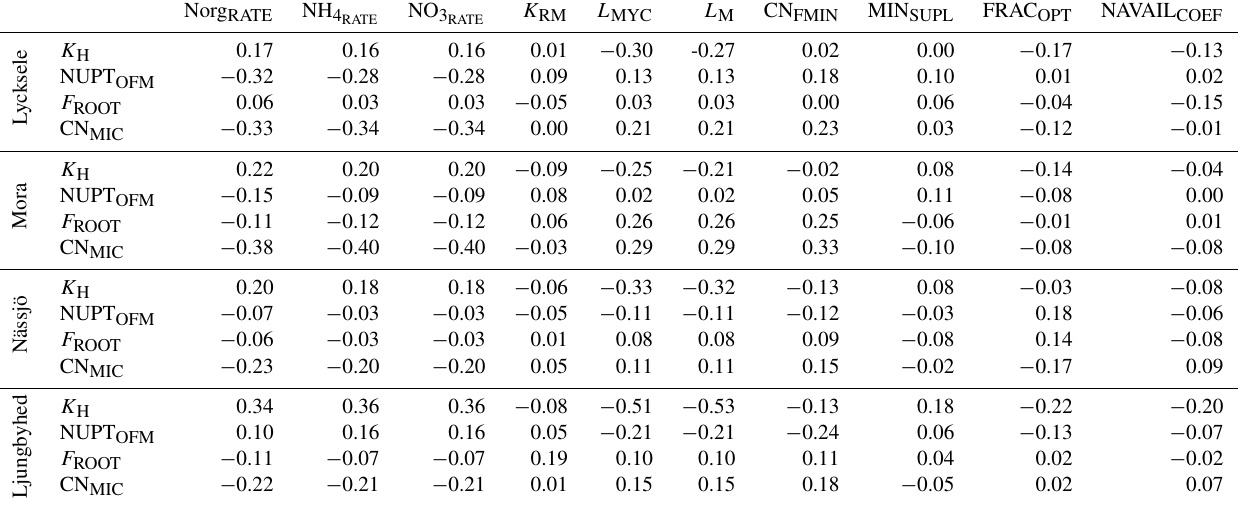
Table A3. Correlation between fungal and common model parameters with the explicit approach for all sites. Correlation is given as the Pearson correlation